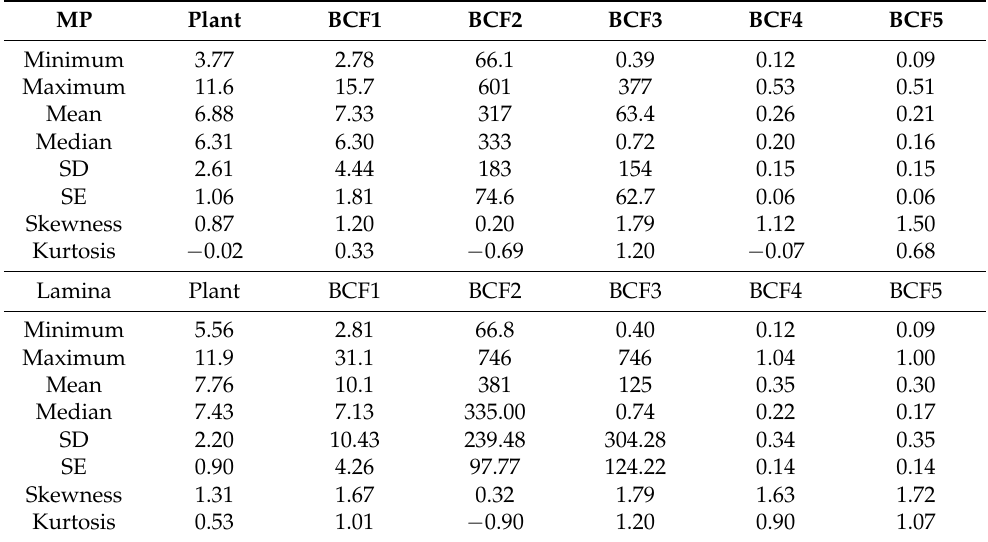
Table 12. Overall statistics of copper (Cu) concentrations (mg/kg dry weight) in the midrib plus petiole (MP), and lamina of Avicennia officinalis , and their bioconcentration factors (BCF) values, collected from 6 sampling sites in the mangrove areas of west coast of Peninsular Malaysia. MP Plant BCF1 BCF2 BCF3 BCF4 BCF5 Minimum